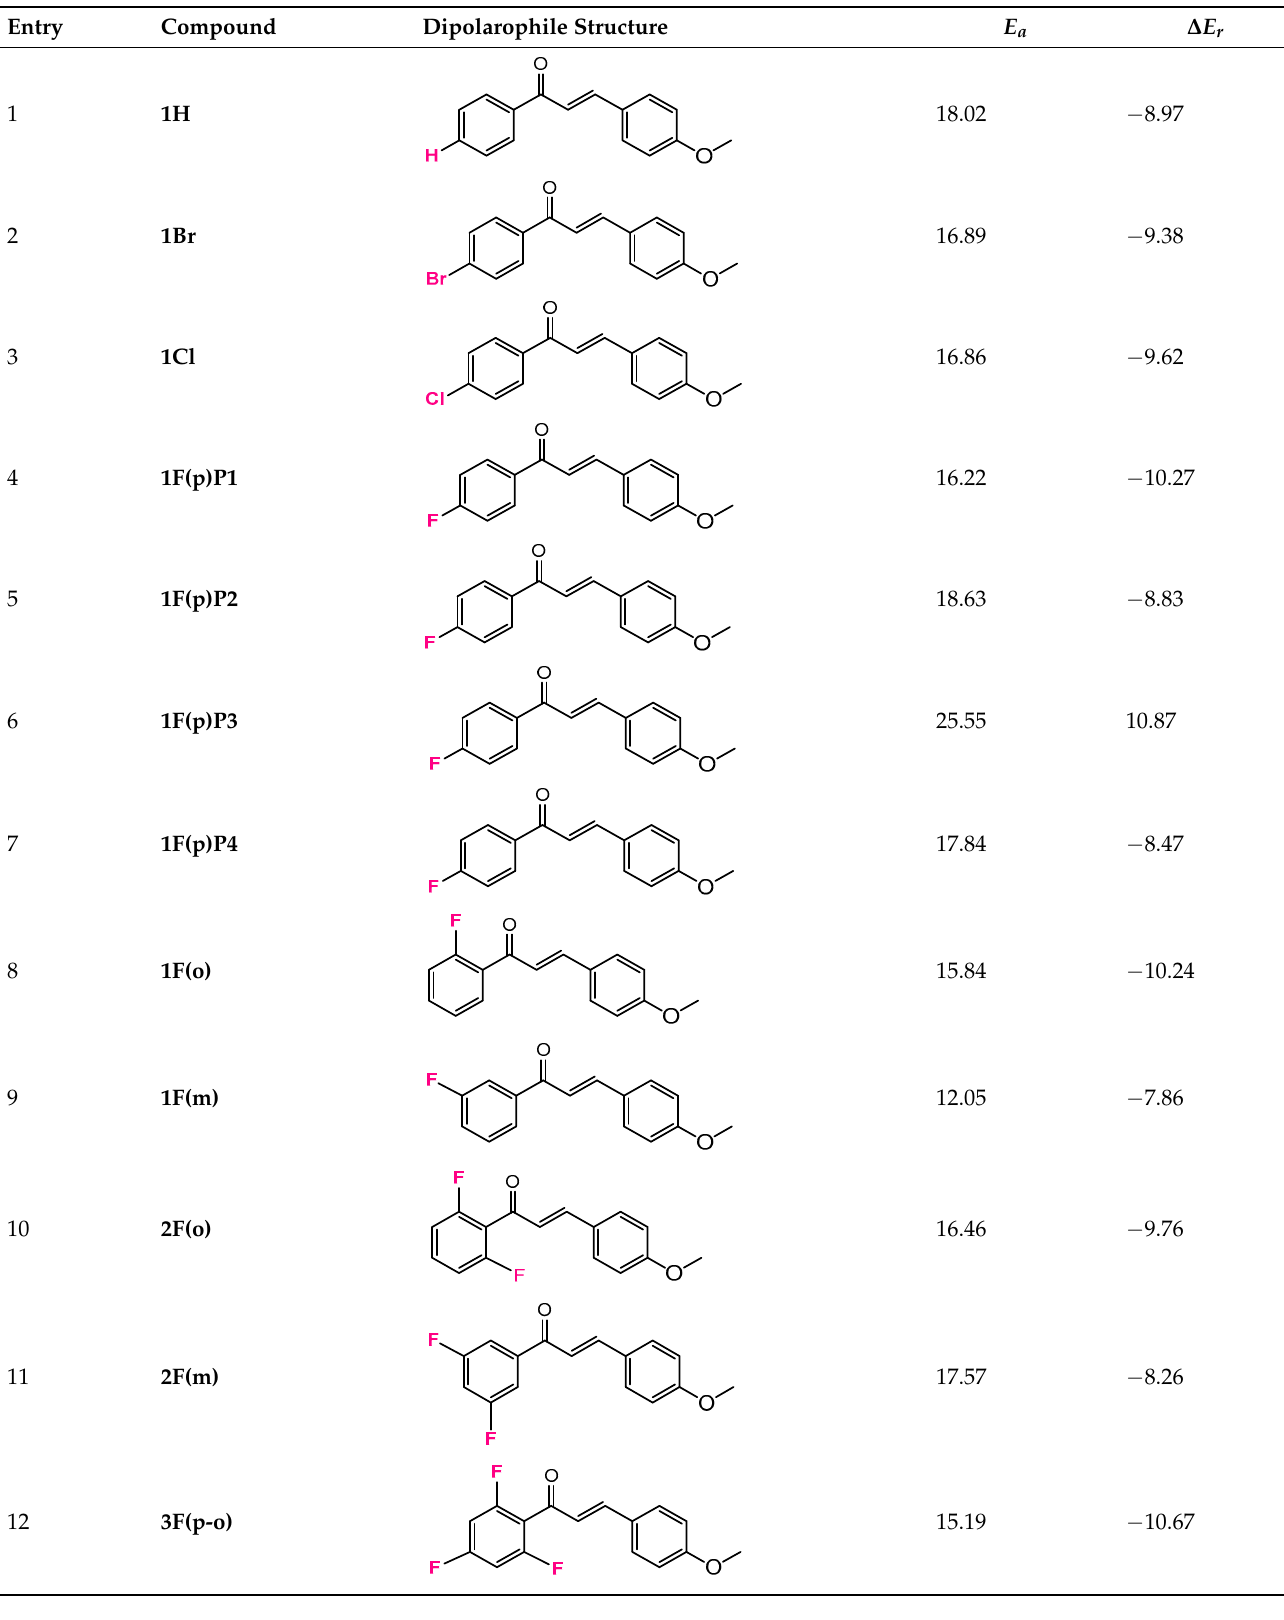
Table 3. Activation energy E a (kcal/mol) and free energy change of reaction ∆ E r (kcal/mol) values of different IRC pathways.